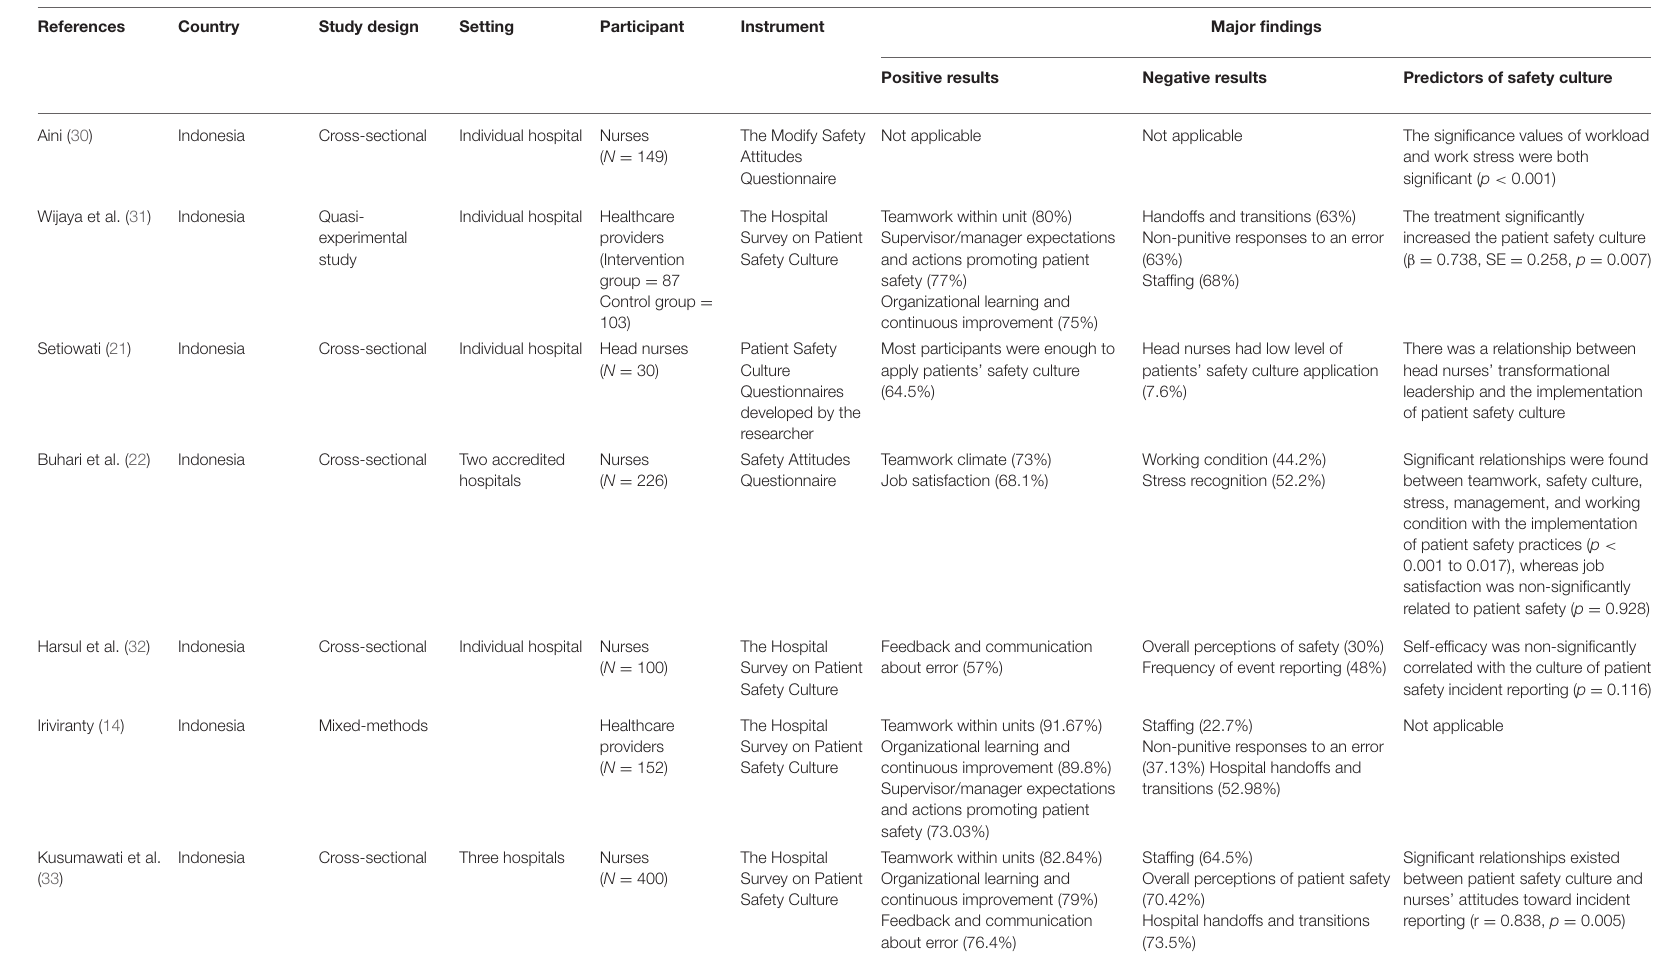
TABLE 2A | Characteristics of patient safety culture and major findings ( N =